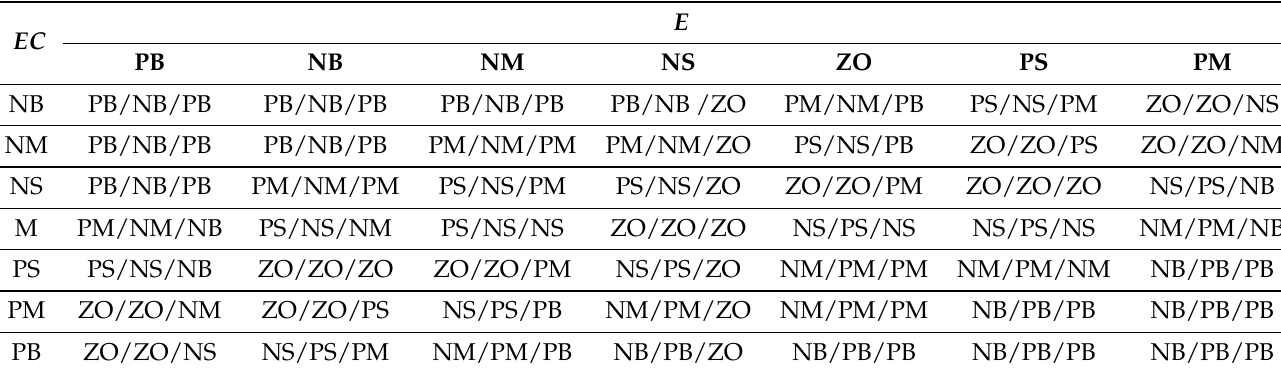
Table 3. Fuzzy rule table of K p , K i , and K d